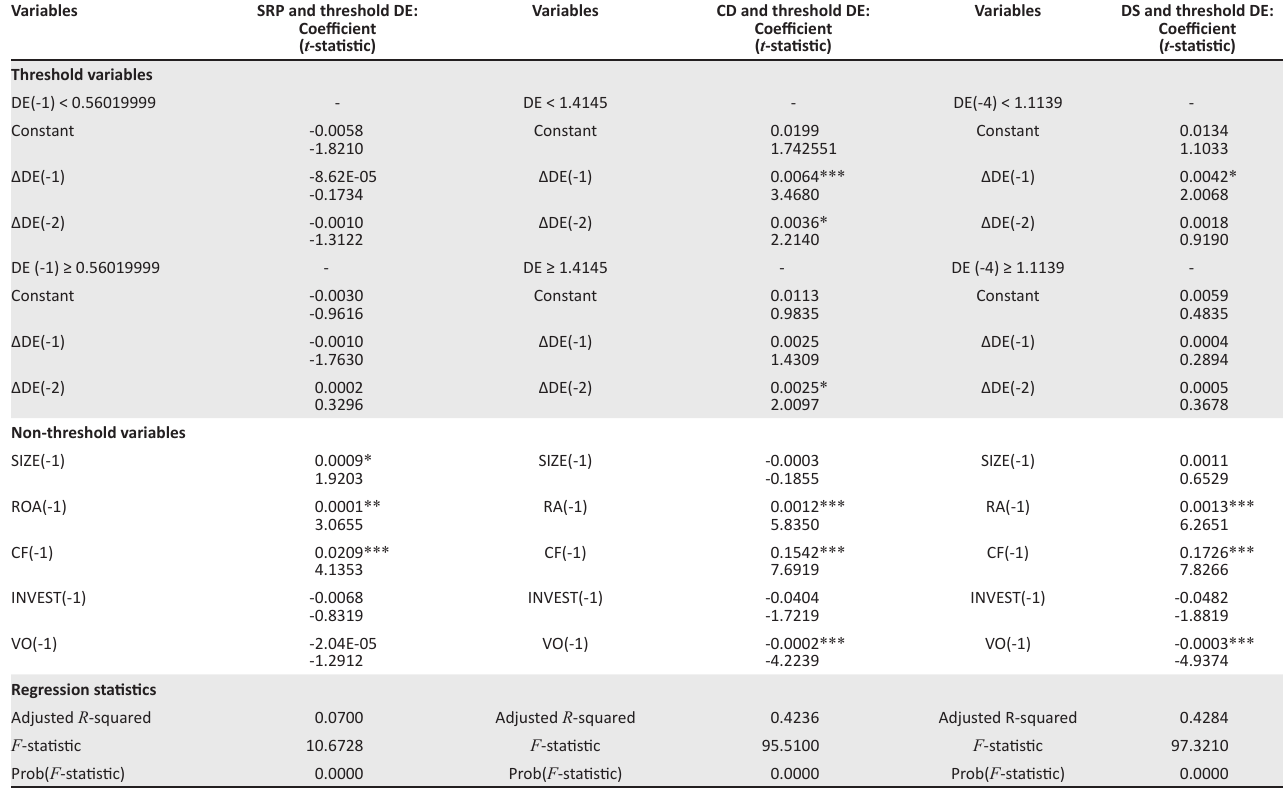
TABLE 3: Threshold regression approach for distribution strategies and the debt-to-equity ratio (trade-off theory): 1999–2017.